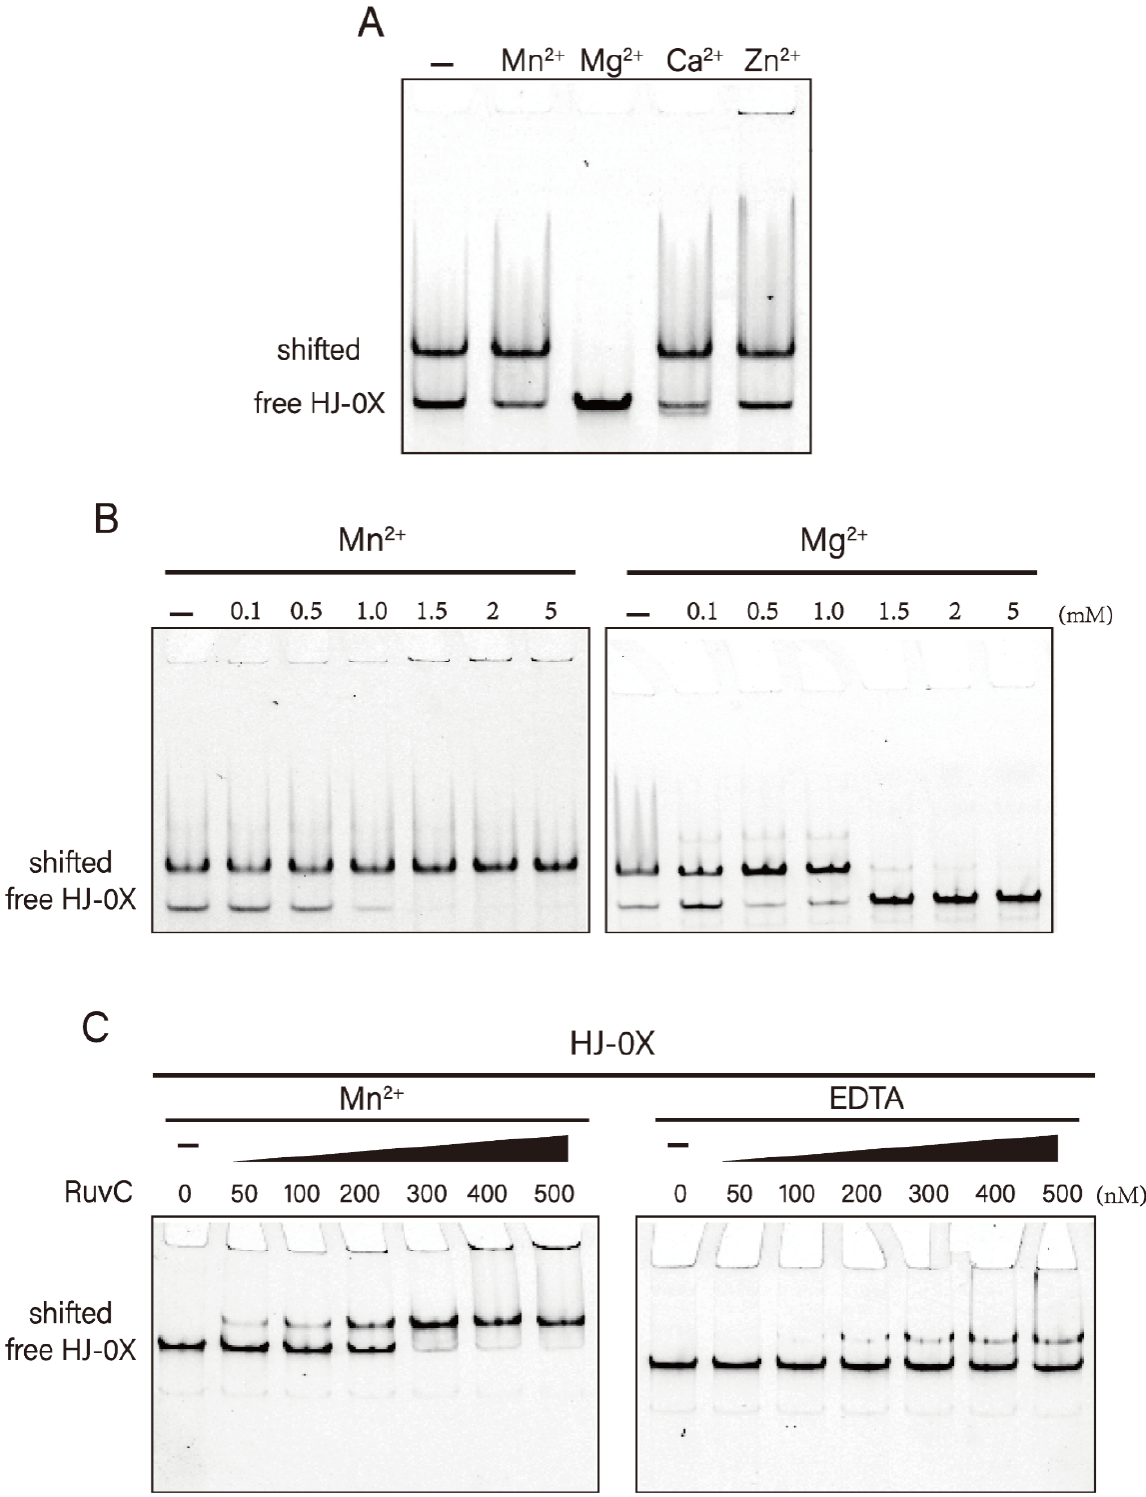
Figure 3. Effect of metal ions on the HJ binding of Dr RuvC. ( A ) The Holliday junction binding abilities of DrRuvC (250 nM) in the absence or presence of indicated metal ions (2 mM). The substrate HJ-0X with non-homologous core was used. ( B ) Mn 2+ and Mg 2+ titration experiments of HJ binding. ( C ) The binding abilities of DrRuvC to HJ-0X in the presence of 1 mM Mn 2+ or in the absence of bivalent metal ions.